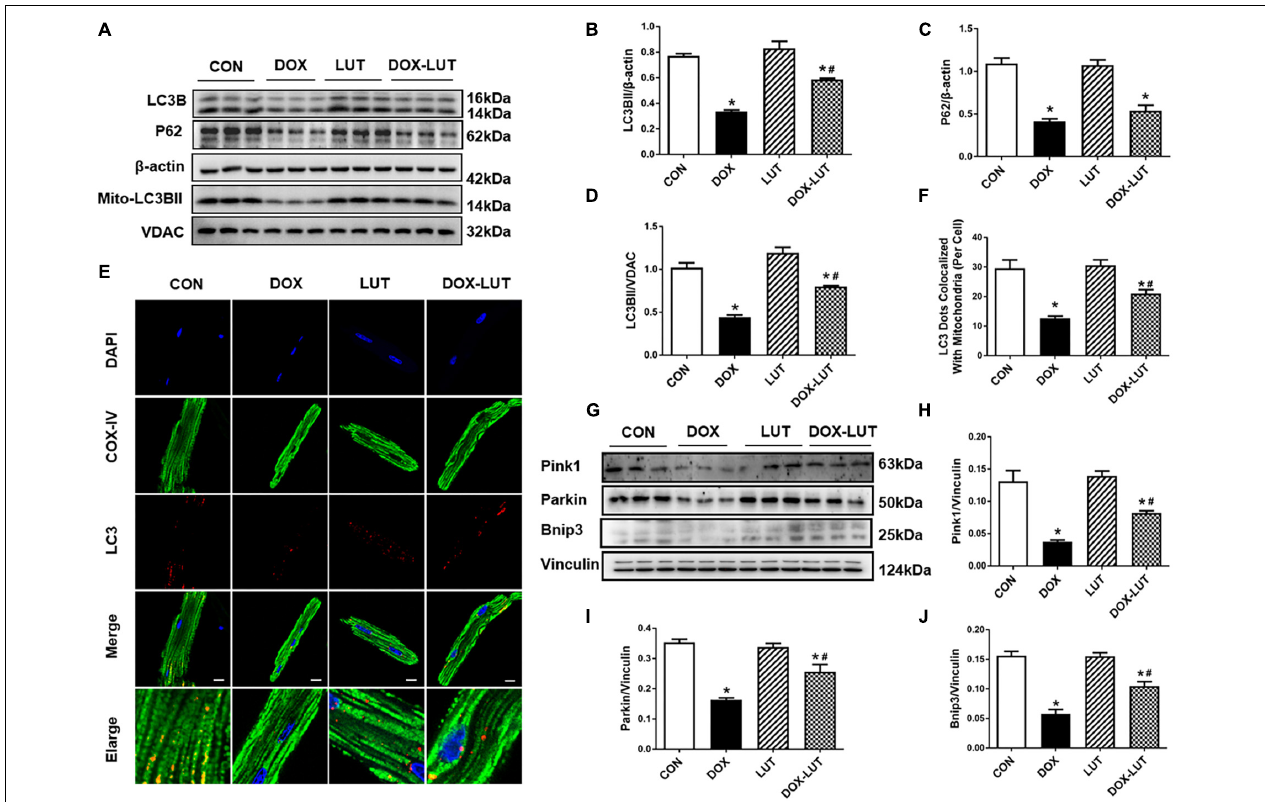
FIGURE 4 | Effect of luteolin treatment on doxorubicin-induced change in cardiomyocyte mitochondrial autophagy. (A) Representative Western gel blots depicting protein levels of mitochondrial autophagy, including LC3B and P62 in cardiomyocytes after doxorubicin and luteolin treatment. (B) LC3B; (C) P62; (D) mitochondrial LC3B; (E) Representative fluorescence images of LC3B co-localized with mitochondria (COXIV) from 9 to 10 fields per group. (F) Quantitative analysis of LC3 dots co-localized with mitochondria. (G) Representative Western gel blots of pink1, parkin and Bnip3; (H) pink1; (I) parkin; (J) Bnip3. Scale bars = 25 µ m. Mean ± SEM, n = 3 independent experiment. * p < 0.05 vs. CON group, # p < 0.05 vs. DOX